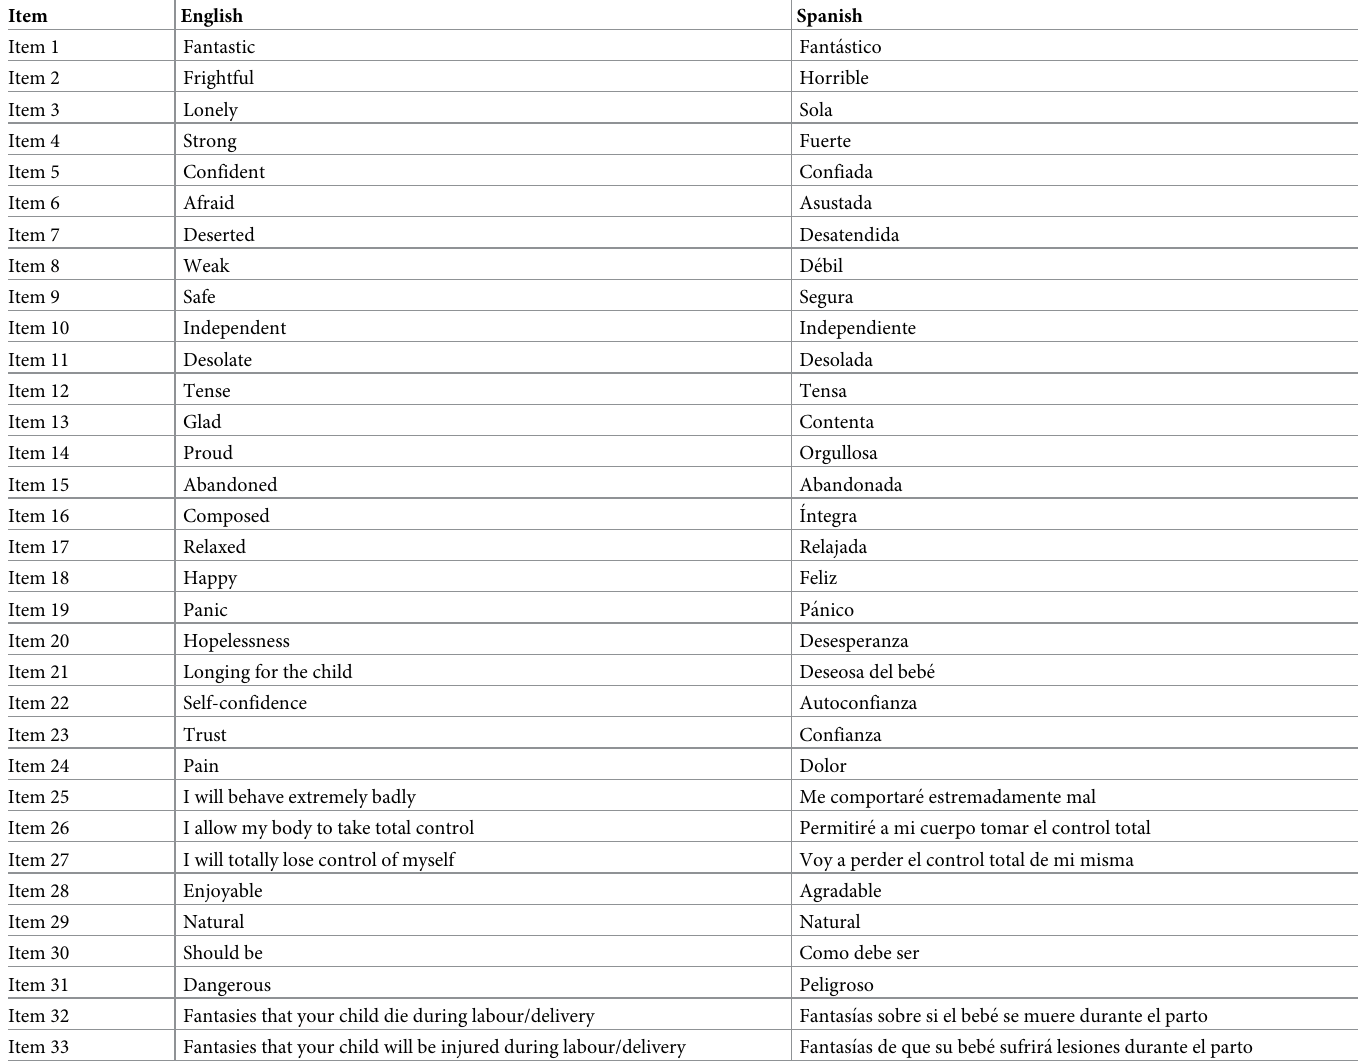
Table 2. Shows the semantic equivalence of items from English to Spanish that were metrically validated on the